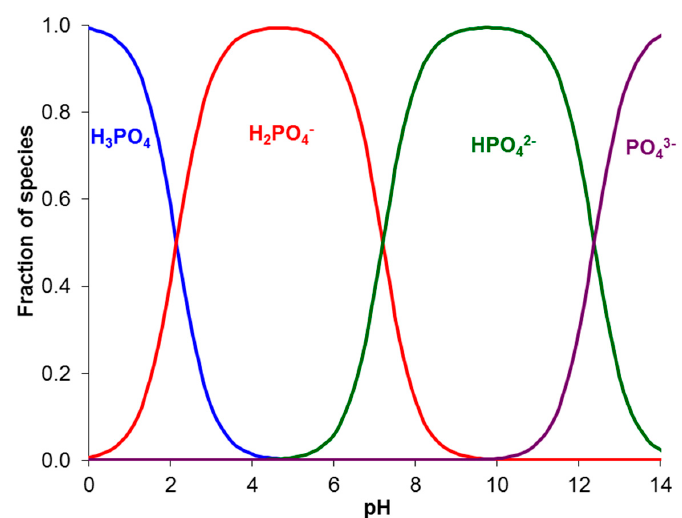
Figure 7. Distribution of the phosphoric acid species (in mole fractions) in a solution as a function of pH.